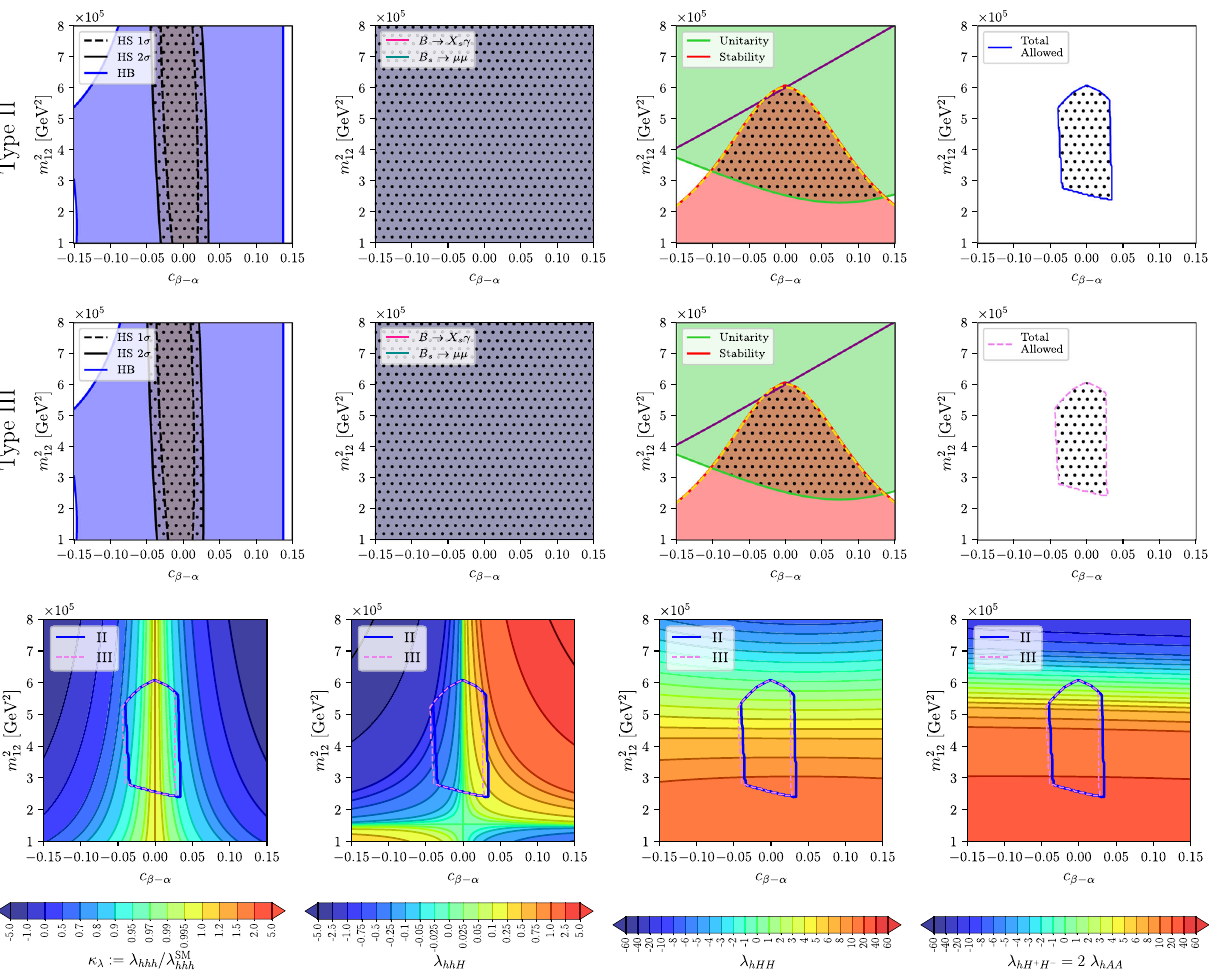
Fig. 8 Allowed areas (dotted regions) from the various constraints in type II (upper row) and type III (middle row) and triple Higgs couplings (lower row) for the benchmark scenario II/III-1 in the c β − α – m plane with tan β = 0 . 9 and m = 1100 GeV κ λ ∼ [ 0 . 66 , 1 ] , where the smallest values are found for the lowest allowed c β − α . The values λ hhH range in λ hhH